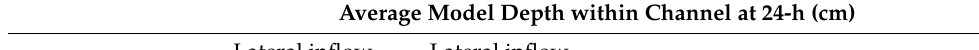
Table 2. Comparison of the model results and steady state water depths for both the constant and variable scenarios: simulated with river flux boundaries and lateral inflows (point source).